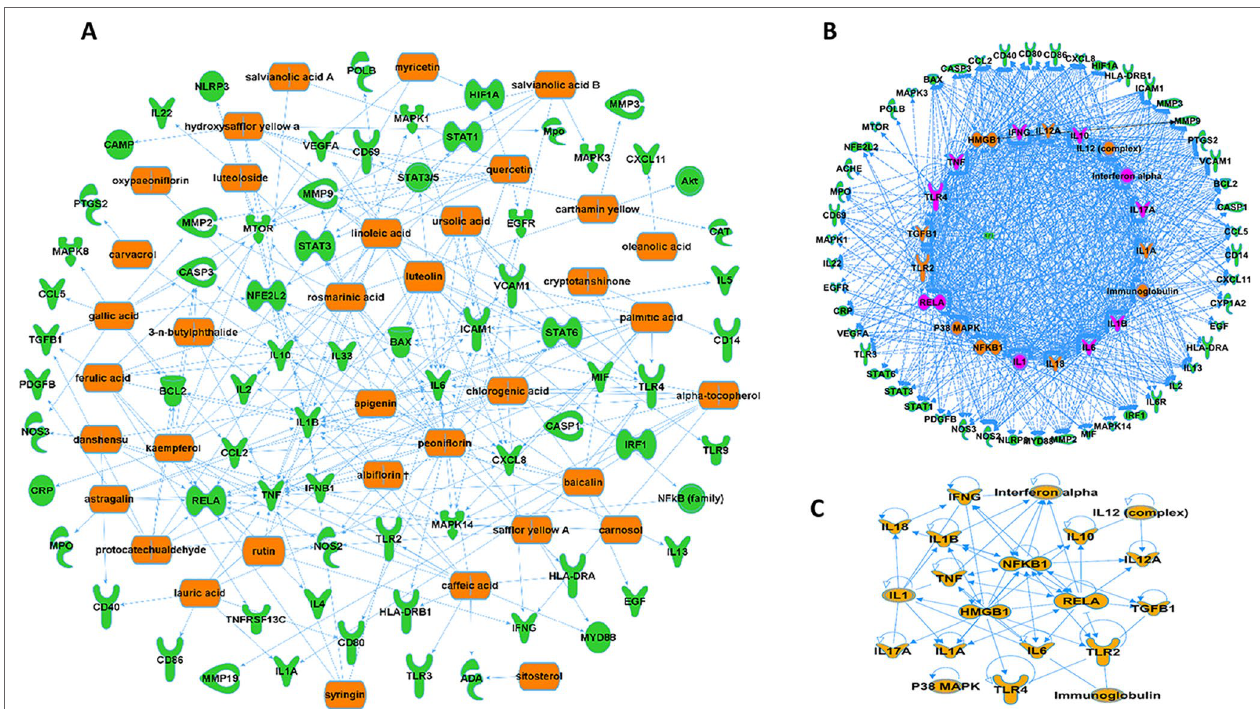
FIGURE 3 | XBJ ingredients regulate potential therapeutic targets of fungal infection. (a) XBJ ingredient-target network predicted by IPA. Thirty-six compounds from XBJ were predicted to cooperatively modulate 72 fungal infection-related targets. (B) Top 20 upstream regulators of potential XBJ targets in fungal infection (top 20 regulators were marked with saffron yellow and top 10 key molecules were labeled with purple-red). (C) The IPA-predicted network of top 20 upstream regulators of potential XBJ targets shown in Figure 3B .